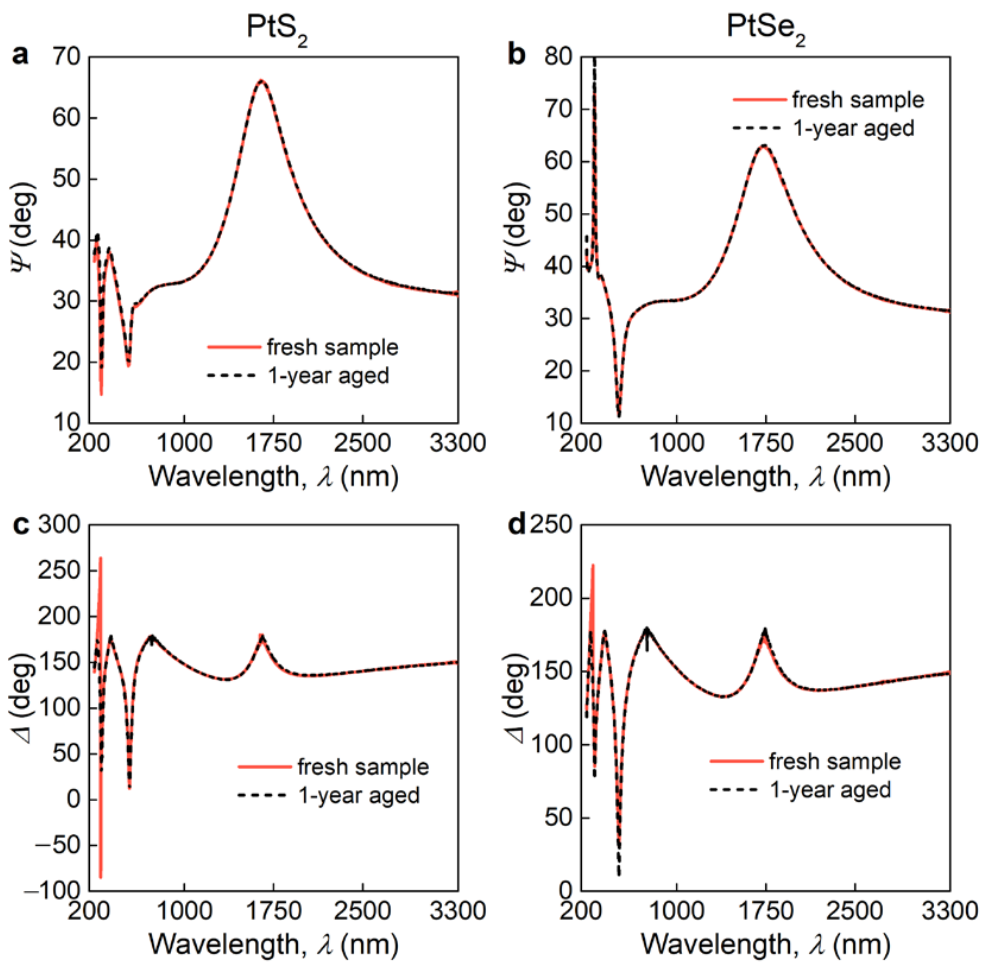
and ( c , d ) for freshly syn- 𝛹𝛹 𝛥𝛥